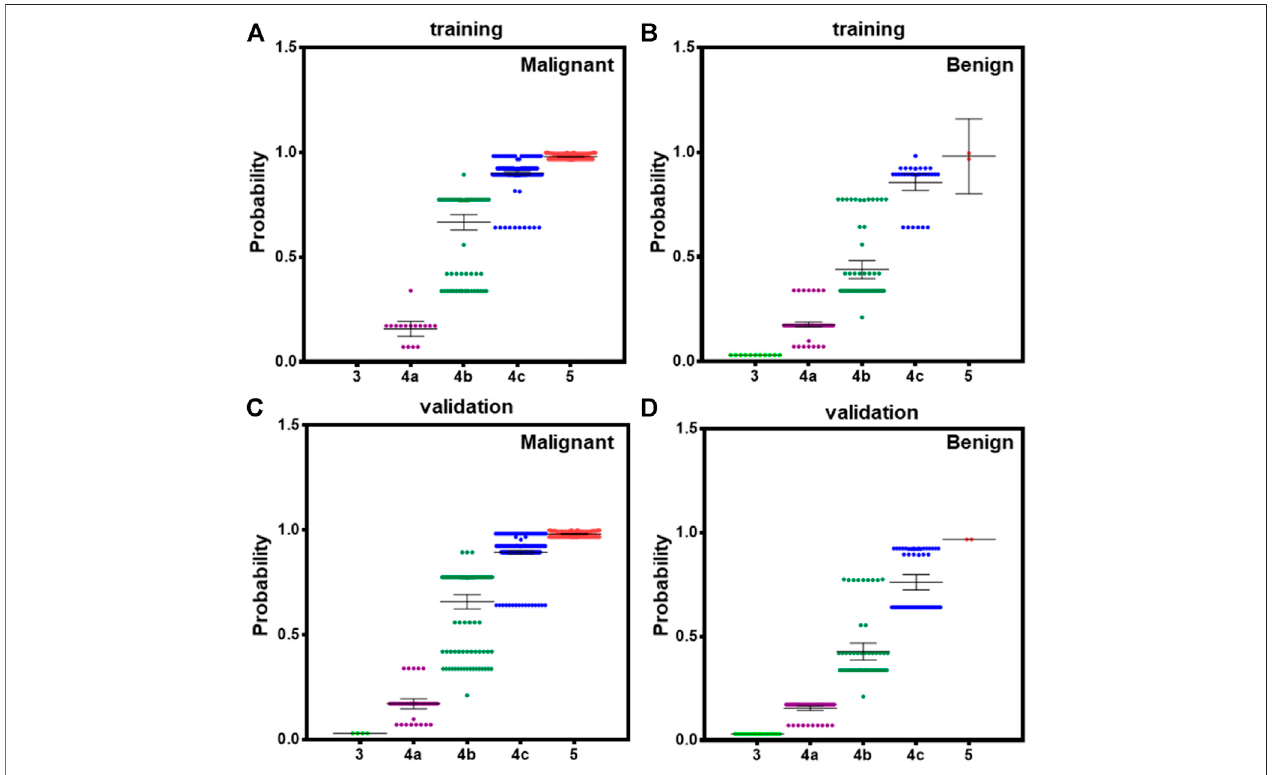
FIGURE 4 | The averaged probability of malignancy predicted by models in different category malignant nodules according to TI-RADS. (A) Malignant cases derived from modeling data, (B) benign cases form modeling data, (C) malignant cases derived from validation data, and (D) benign cases form validation data. Bars indicate the 95%CI.